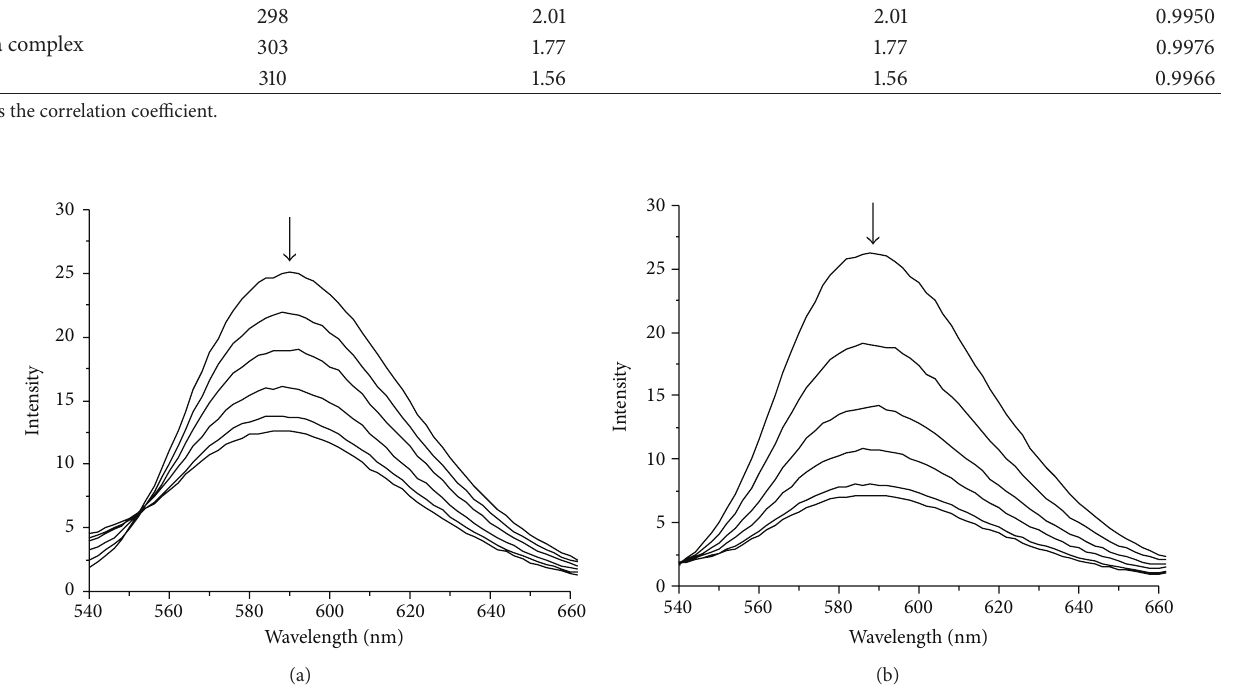
Figure 3: Emission spectra of DNA-EB with various concentrations of ligand L (a) and La (III) complex (b) at 298 K, [EB] = 50 𝜇 M, [DNA] = 200 𝜇 M, and [compound] = 0, 30, 60, 90, 120, and 150 𝜇 M, respectively. The arrow shows the intensity changes on increasing the compound concentration.